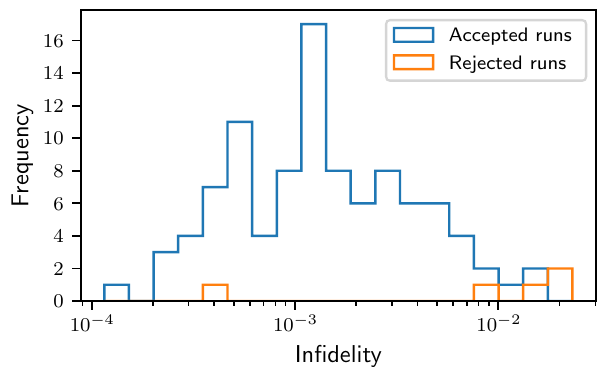
FIG. 11. Histogram of gate infidelities due to imperfect cal- ibration. Randomized benchmarking is used to compute a per- gate infidelity from the difference of the final parameter estimates of independent calibration runs compared to their mean value (Fig. 10). We calculate a median infidelity of 1.3 ( 1 ) × 10 − 3 caused by imperfect calibration and a 95 percentile of 7.4 × 10 − 3